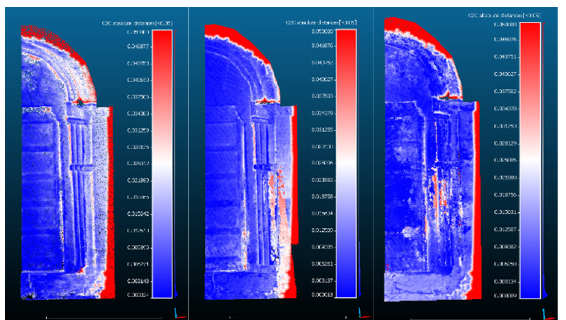
Figure 8. C2C analyses between the freestyle 3D model and the three considered imagery sensors models (from left: Steadycam, Compact camera,